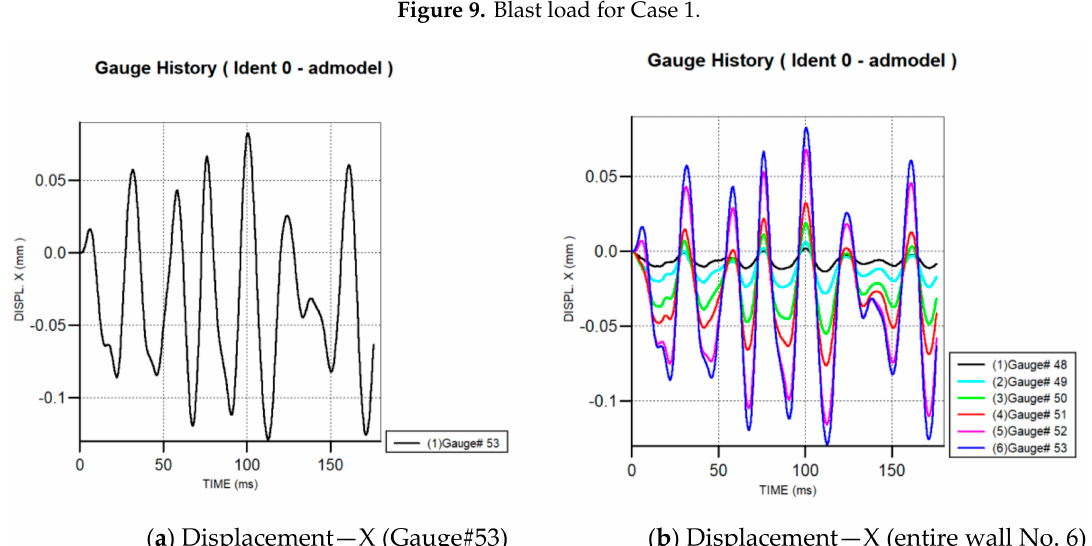
Figure 9. Blast load for Case 1.